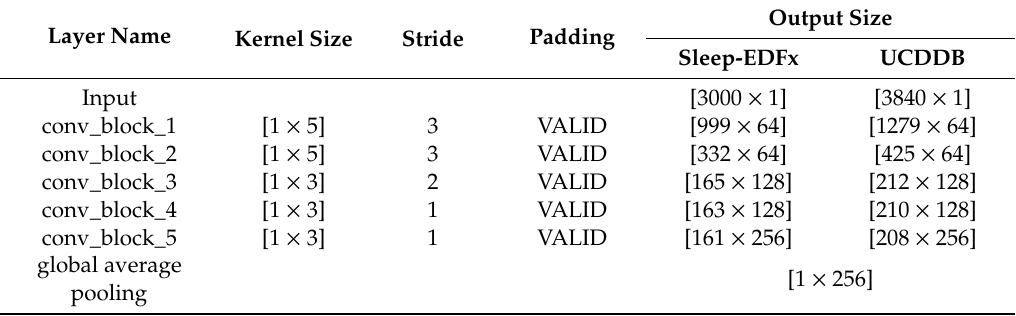
Table 2. Hyperparameters of convolution neural network